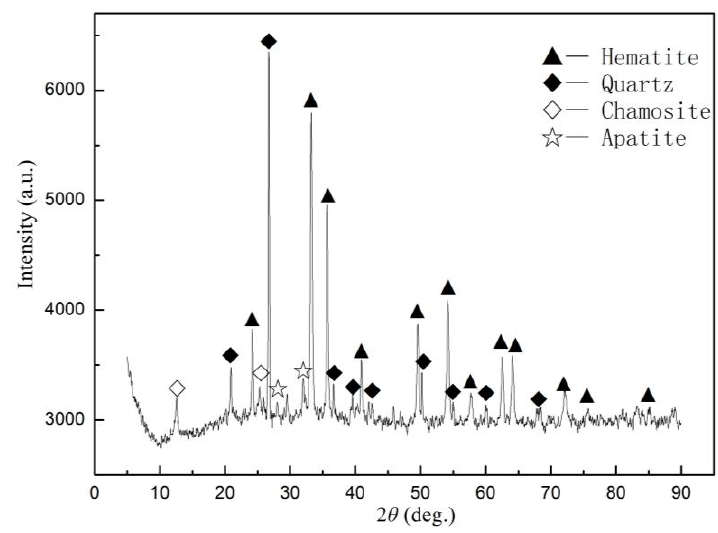
Figure 1. XRD pattern of oolitic hematite sample.